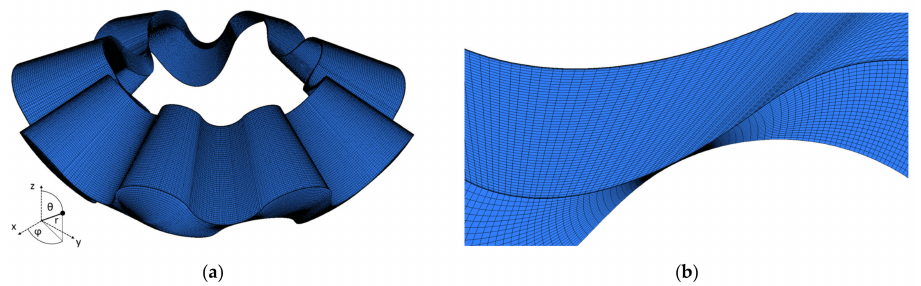
Figure 8. Mesh of the displacement chambers ( a ) and meshing details of the gap between the gear teeth ( b ) of the TMC pump.